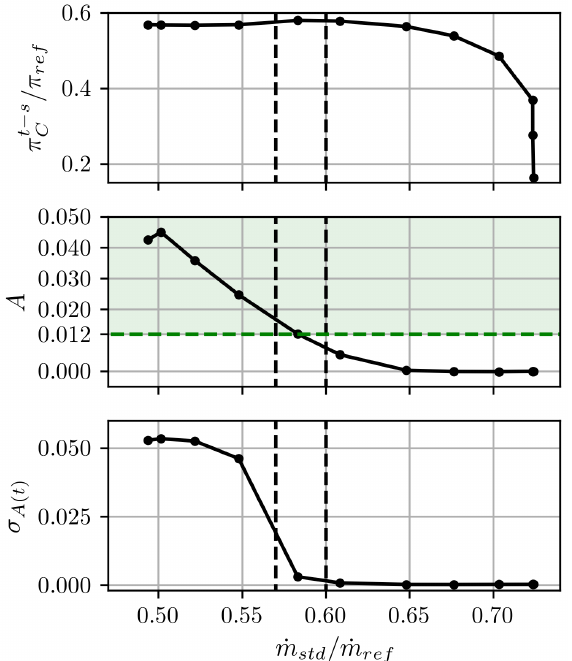
Figure 3. Evolution of the alternate pattern with respect to standard mass flow rate at an IGV stagger angle of 0 ◦ : total-to-static pressure ratio ( top ), steady alternate rate ( middle ), and unsteady alternate rate standard deviation ( bottom ).